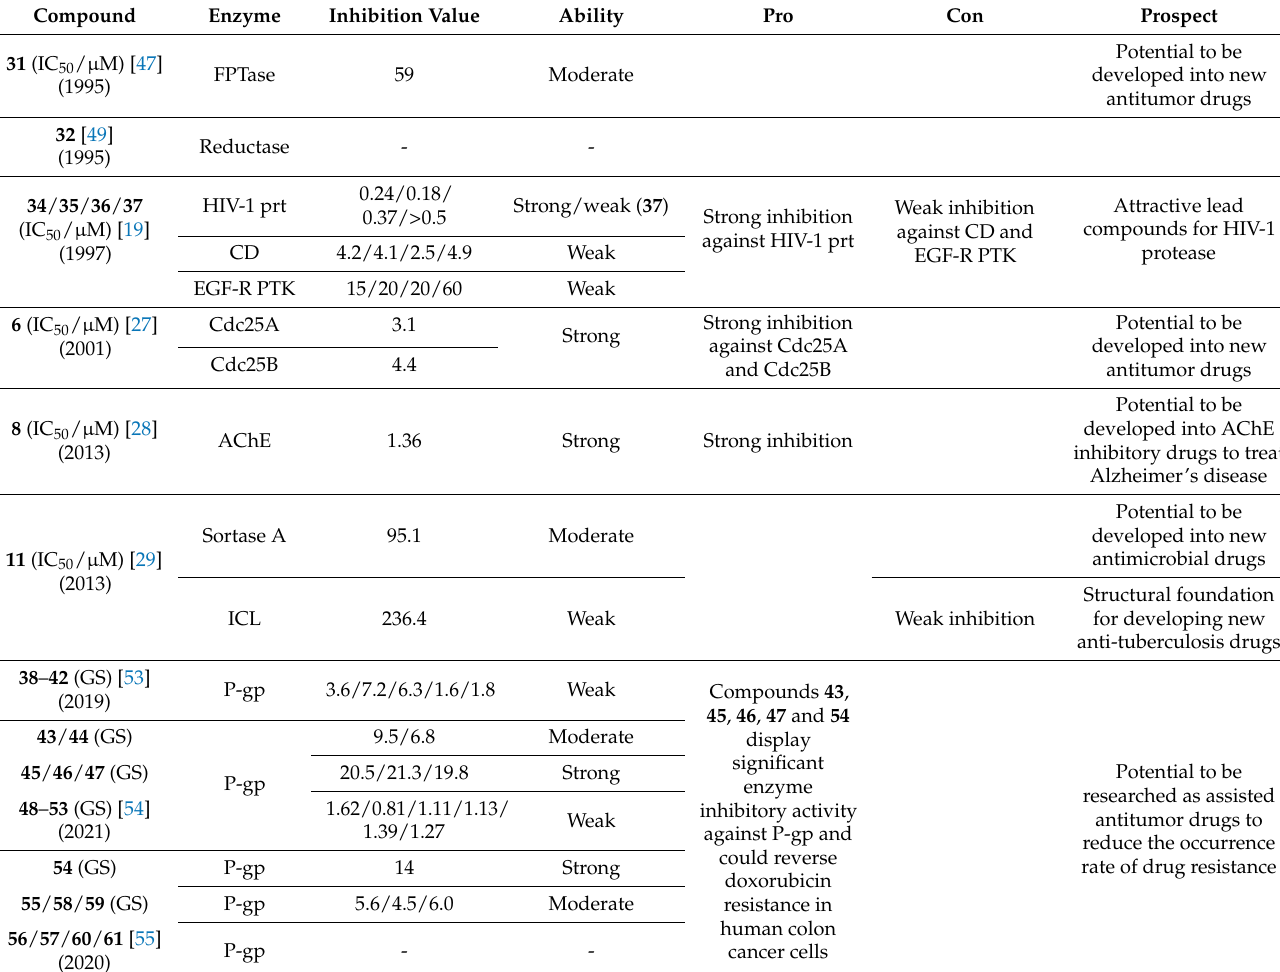
Table 3. Compounds with enzyme